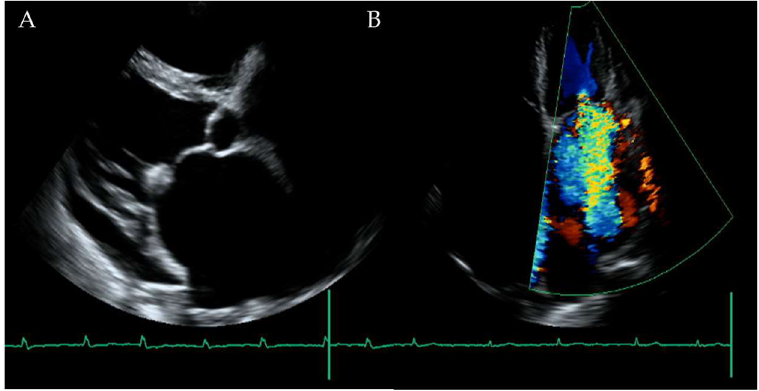
Figure 2. Chest x-ray showing cardiomegaly and right pleural effusion.